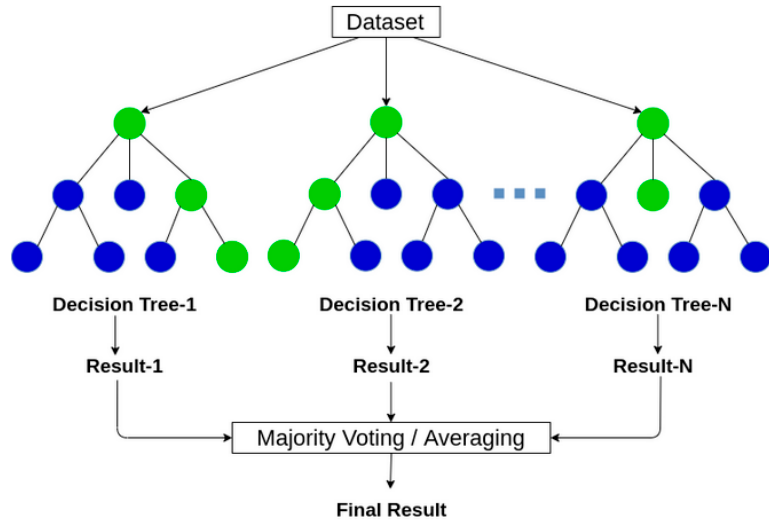
Figure 5. Typical architectures of bagging or random forest models. The algorithms are different depending on the way the regression trees are built.